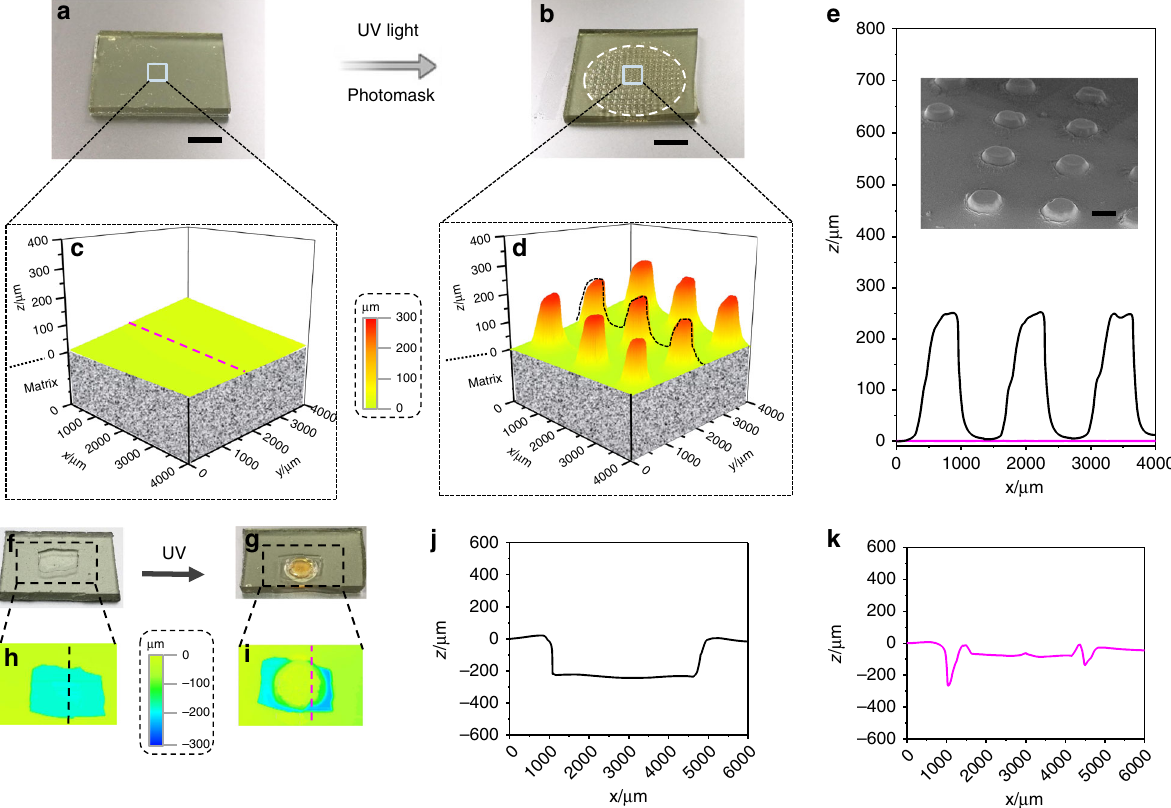
Fig. 4 Application demonstration of light-induced growth. a – e Microstructure pattern grown from a fl at substrate (scale bar: 8 mm): a swollen seed-20%; b formed microstructure. The dashed line highlights the irradiated zone. 3D pro fi les of the surfaces of the swollen seed-20% ( c ) and the grown sample ( d ). e Surface pro fi les of the seed − 20% and the formed microstructure. The regions are highlighted by dotted lines in ( c ) and ( d ). The inset in e shows the SEM image of the growth pattern. Scale bar: 500 μ m. f – k Restoration of large-scale surface damage by light-induced growth: f images of the swollen seed-20% with damage of 0.60 cm ( l ) × 0.40 cm ( w ) × 0.22 mm ( h ) then treated with UV light ( g ). Top view of the 3D pro fi le of the damaged swollen seed-20% ( h ) and the grown swollen seed-20% ( i ). Surface pro fi les of the damaged area before ( j ) and after ( k ) healing. A photomask was used for UV irradiation, and the irradiation time was 30 min. The scale shows the height. The dashed lines in ( h ) and ( i ) highlight the positions used for the collection of the pro fi le